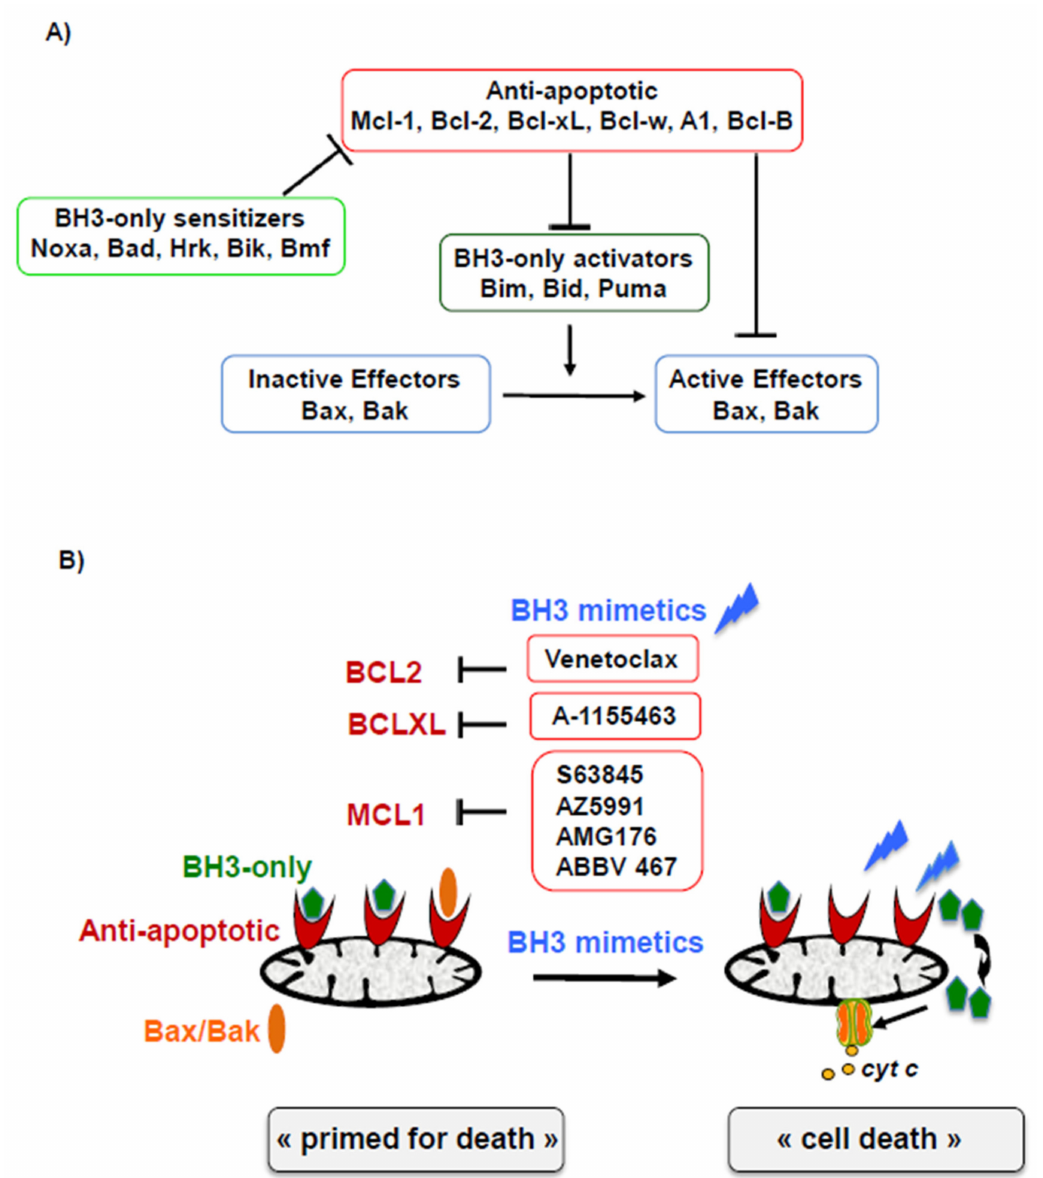
Figure 1. Interconnected network of B-cell lymphoma (BCL-2) family proteins. ( A ) The BCL-2 family consists of three groups: anti-apoptotic members (MCL-1, BCL-2, BCL-X L , etc.), pro-apoptotic BH3-only proteins, and the pro-apoptotic e ff ectors BAX and BAK. BH3-only proteins can activate BAX-BAK either directly (BH3-only activators), inducing conformational changes of BAX / BAK or indirectly (BH3-only sensitizers), interacting with the anti-apoptotic counterparts and in turn inducing the release of constitutive activated e ff ectors BAX / BAK. Cancer cell constrain pro-apoptotic proteins via physical interactions with anti-apoptotic counterparts, termed “primed for death”. ( B ) BH3 mimetics bind specifically anti-apoptotic BCL-2 members, releasing pro-apoptotic BH3-only and / or e ff ectors BAX / BAK, which in turn trigger the apoptotic cascade leading to cell